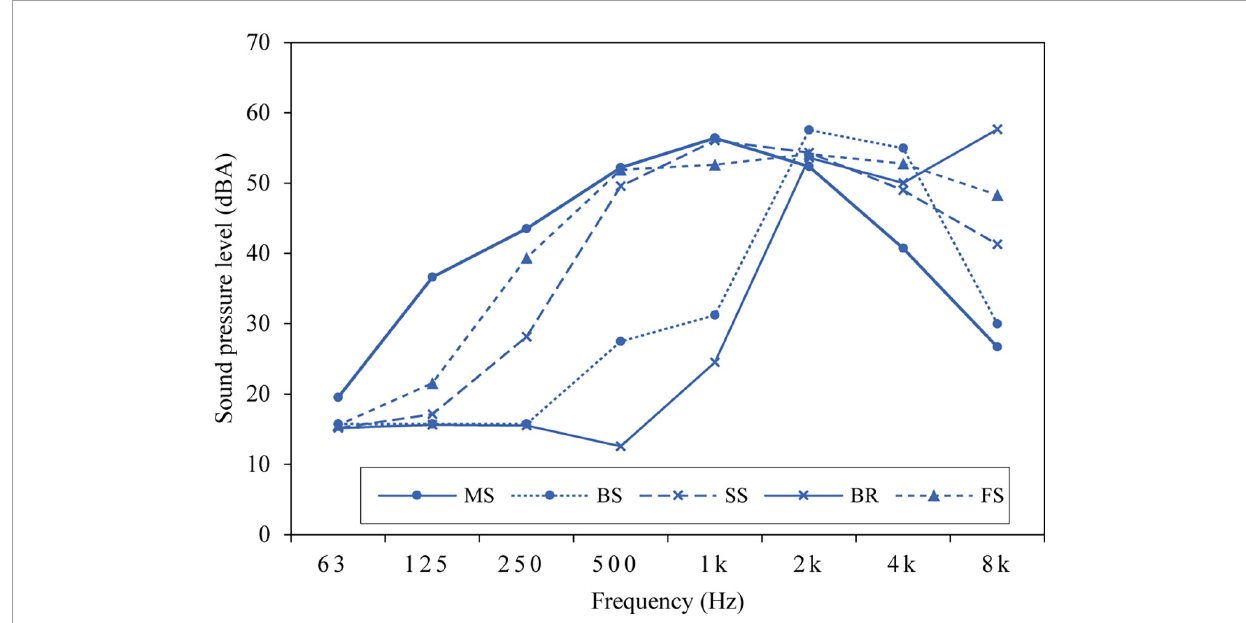
FIGURE3 The spectra of the five potential restorative sounds. MS, music; BS, birdsong; SS, stream sound; BR, bell ring; FS, fountain sound.